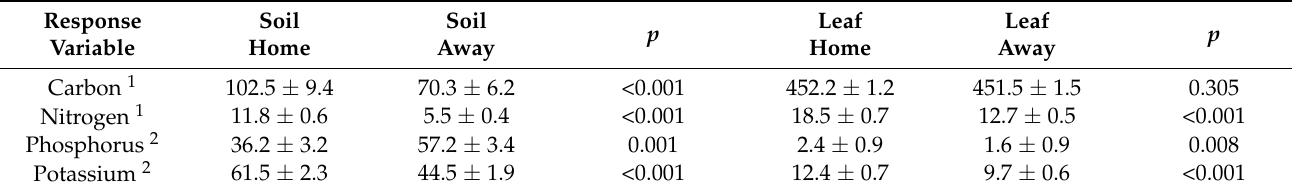
Table 1. Characteristics of soil and Serianthes kanehirae leaves from plants grown in Home versus Away soils. The Home soils were obtained from the rhizosphere of a Serianthes nelsonii tree in northern Guam. The Away soils were obtained from a 50–70 band surrounding the tree. Significance was determined by a t -test, n = 6.